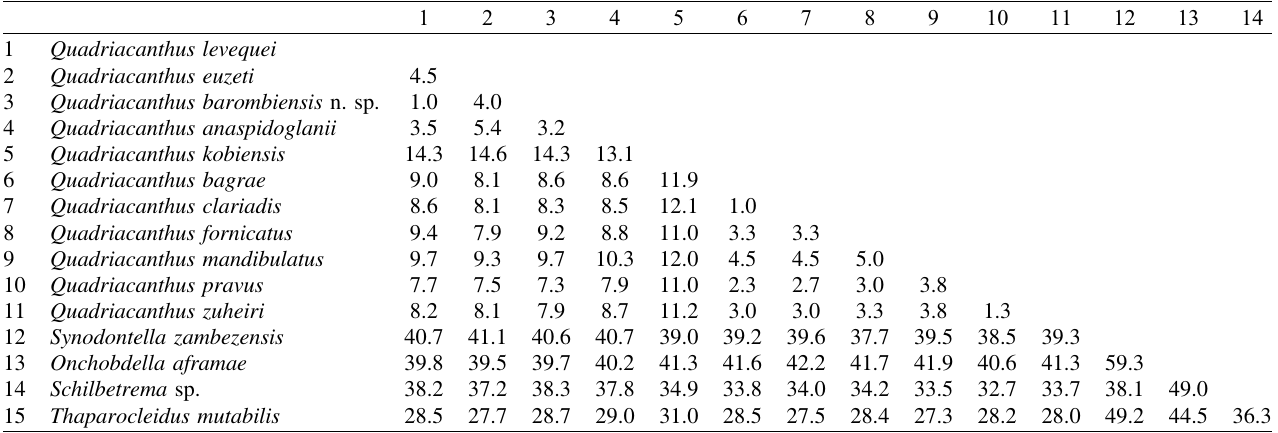
Table 3. Matrix of Gamma-corrected pairwise distances (in %) between 28S rDNA sequences of 616 bp length of the 15 dactylogyridean